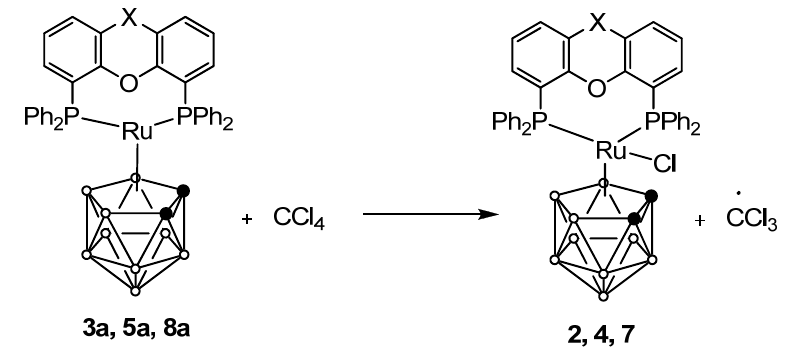
Scheme 7. Reaction of 16-e species with CCl 4 . Table 4. The calculated energy changes for the reactions depicted on Scheme 6 (I) and Scheme 7 (II). Energy Change in Reaction, Ligand